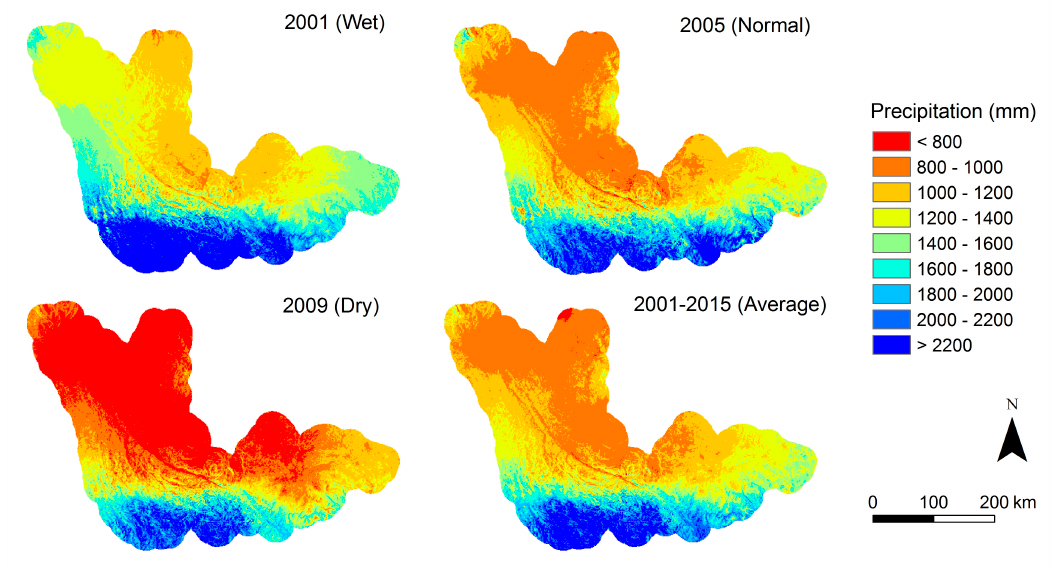
Figure 9. Final calibrated downscaled annual precipitation with 1-km resolution for three reference years and the entire time period.